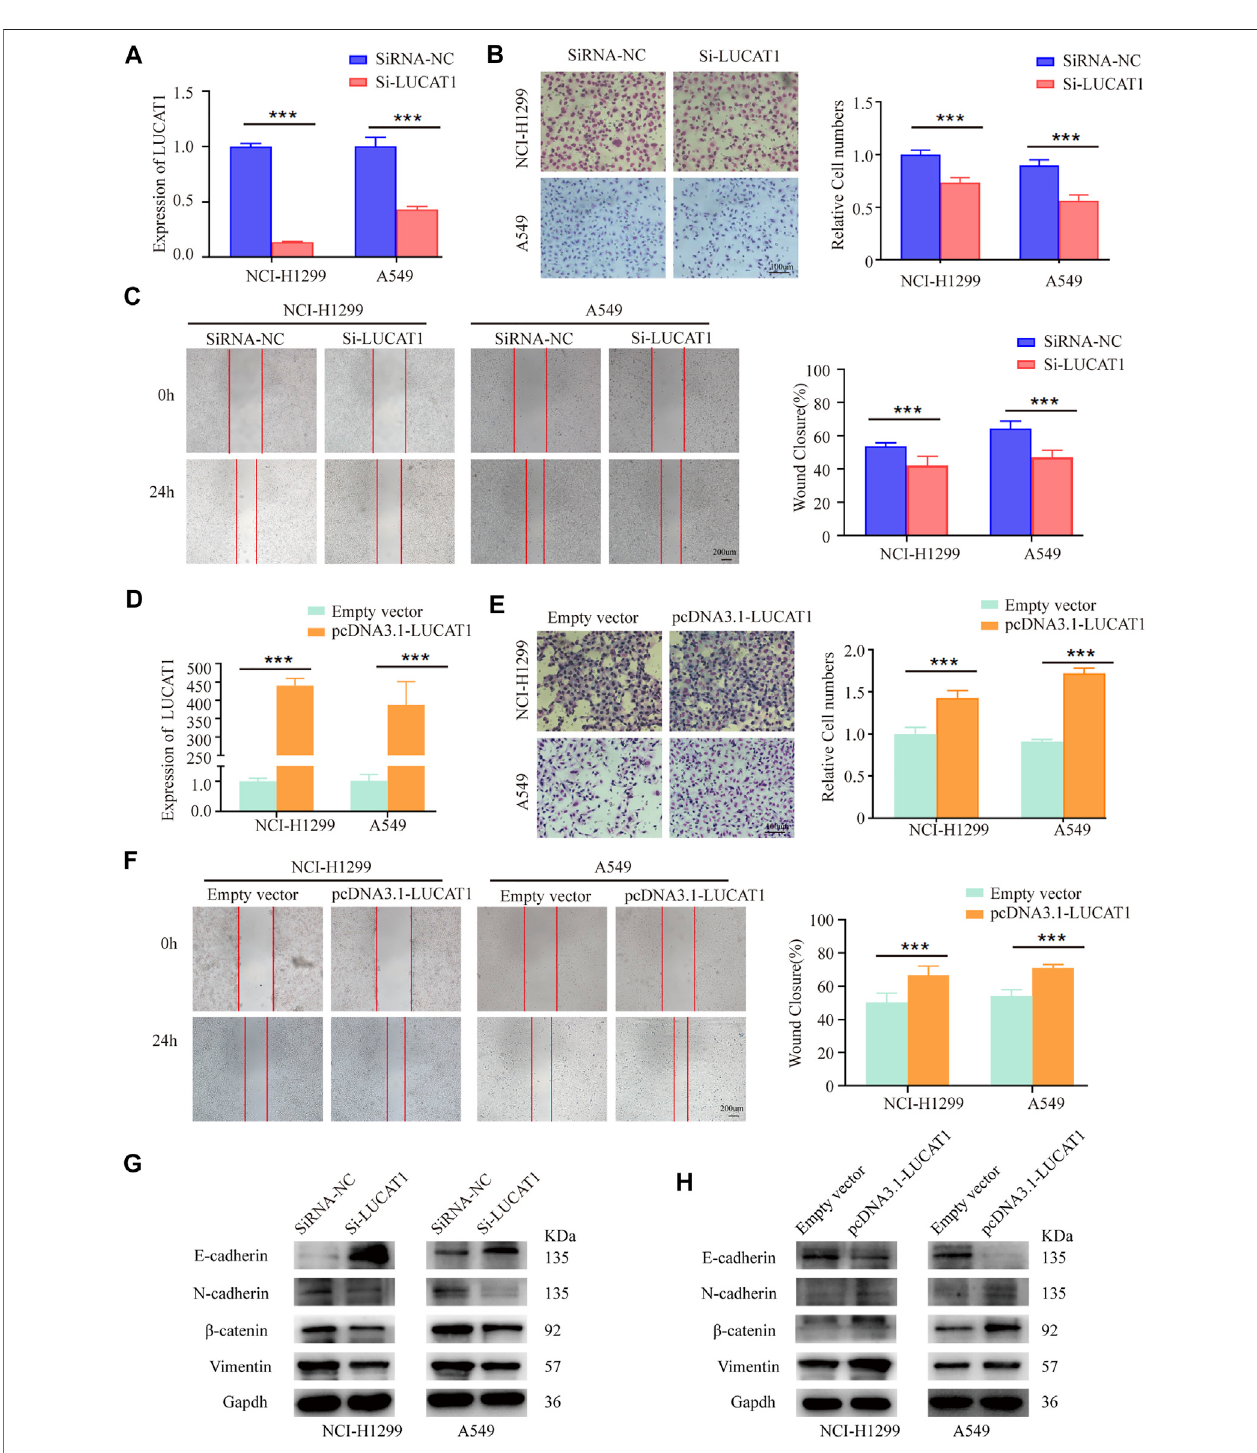
FIGURE3| LUCAT1 promotes migration and invasion of LUAD cells in vitro . (A) LUCAT1 silencing ef fi ciency of NCI-H1299 and A549 cells were veri fi ed by qRT-PCR analysis. (B) Transwell assay for investigating invasion change in NCI-H1299 and A549 cells after LUCAT1 knockdown, Scale bar: 100 µm. (C) The migration of LUCAT1-silenced LUAD cells were detected by wound healing assay. Scale bar: 200 µm. (D) The relative mRNA levels of LUCAT1 in LUAD cells transfected with pcDNA3.1-LUCAT1, or control. (E) Transwellassay wereperformedtodeterminetheinvasion changein NCI-H1299andA549cellsupon LUCAT1 was overexpressed. Scale bar: 100 µm. (F) The migration of LUCAT1-overexpression LUAD cells were detected by wound healing assay. Scale bar: 200 µm. (G,H) The relative expression levels of E-cadherin and vimentin were determined by western blot in NCI-H1299 and A549 cells with LUCAT1 knockdown. Comparisons between two groups were analysed using two-sided paired t-test (* p < 0.05; ** p < 0.01; *** p < 0.001).